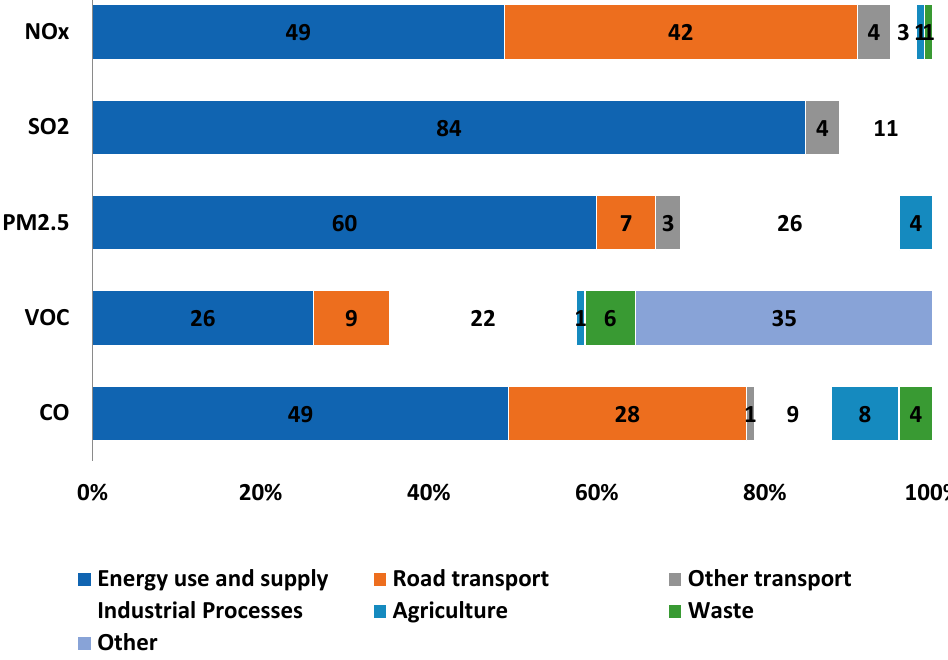
Figure 4. Air pollutant emissions.